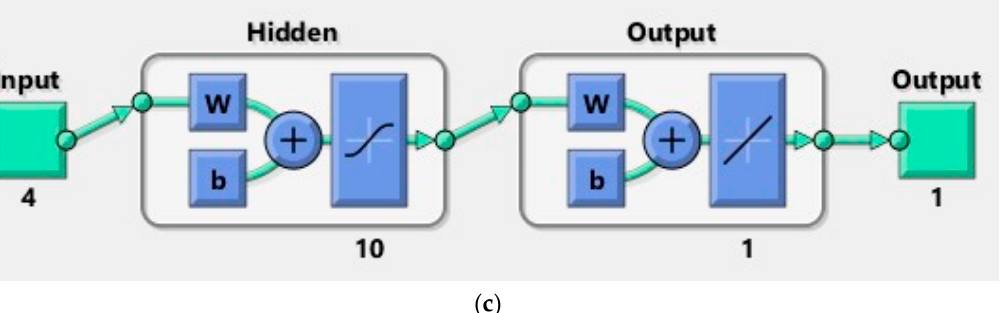
Figure 3. ( a ) The layered structure of the developed ANN models for SFC. ( b ) Structural topology of the ANN model for the non-magnetized flow field. ( c ) Structural topology of the ANN model for the magnetized flow field. Table 9. The output and input parameters for each developed model. Model Inputs Output Model 1 ( M = 0)